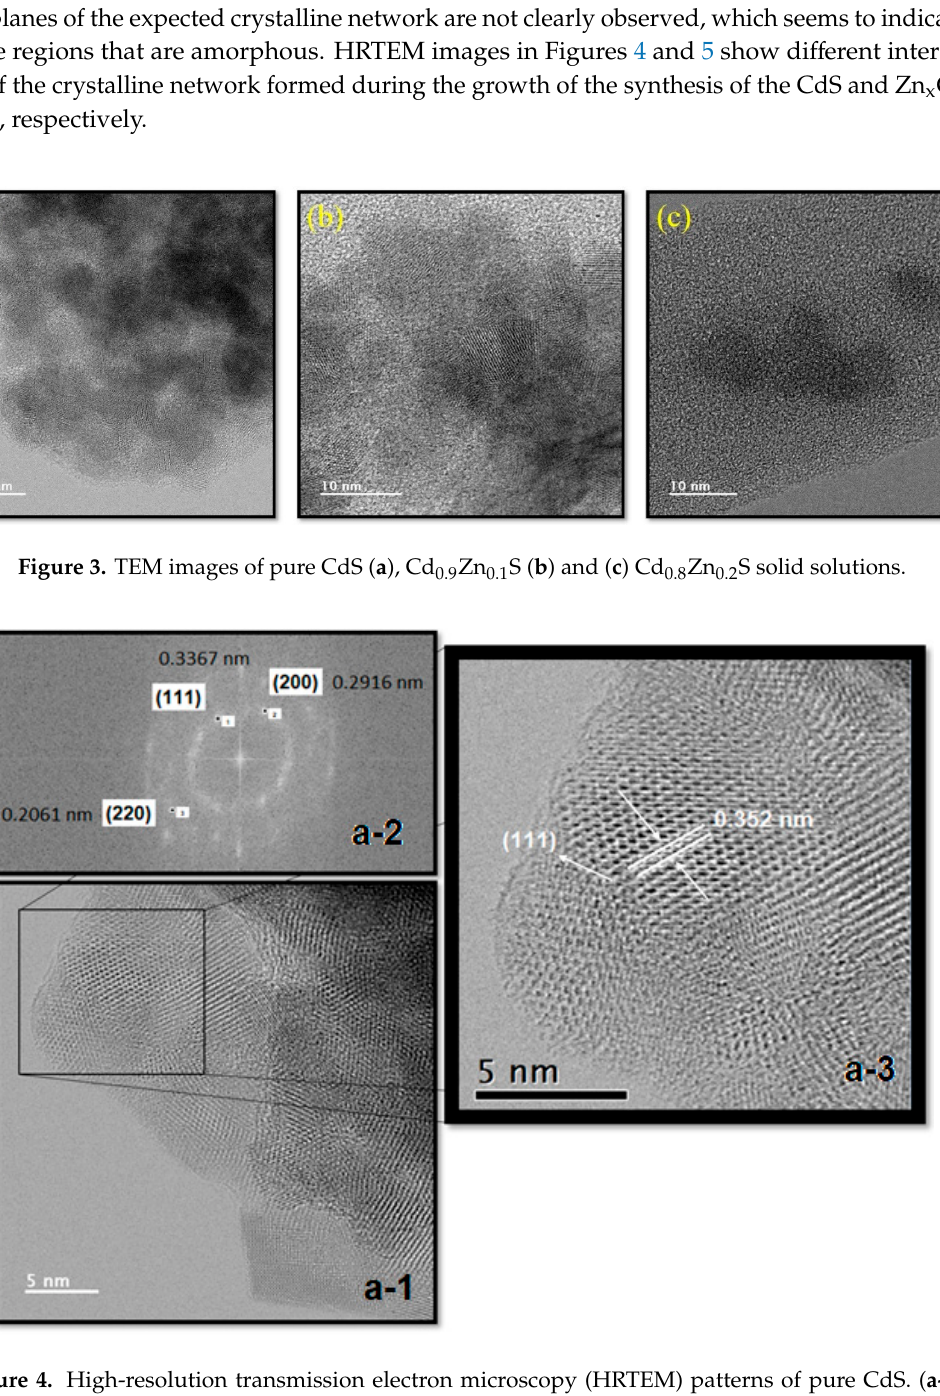
Figure 4. High-resolution transmission electron microscopy (HRTEM) patterns of pure CdS. ( a-1 ) The growth patterns (randomly oriented polycrystalline material), ( a-2 ) the selected portion shows the Fourier Transformed from a-1, and ( a-3 ) shows the interplanar spacing between planes.